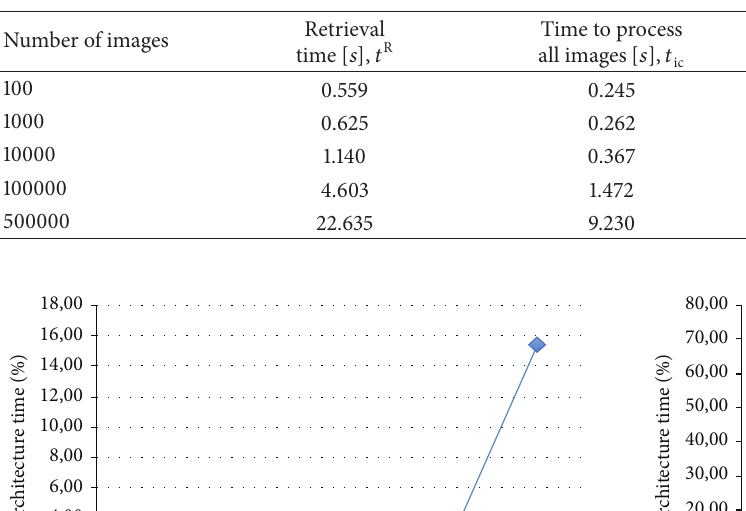
Table 2: Retrieval phase performances (i.e., Spark based).